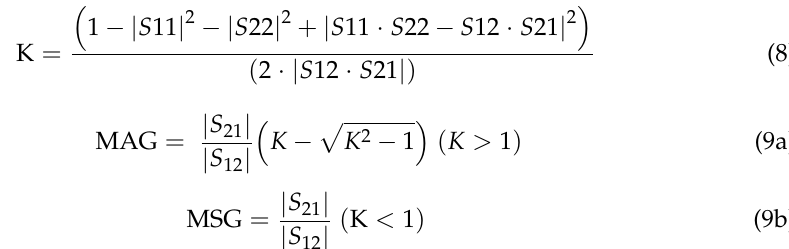
ds ” circuit with the EM sim-